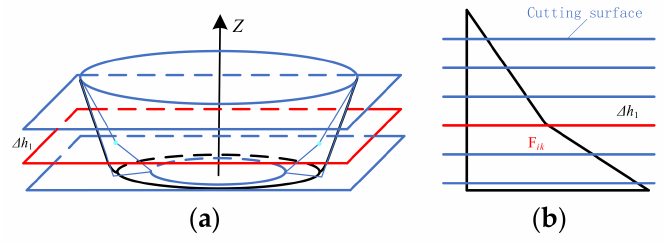
Figure 6. Toolpath generation method: ( a ) stereogram and ( b ) longitudinal section.